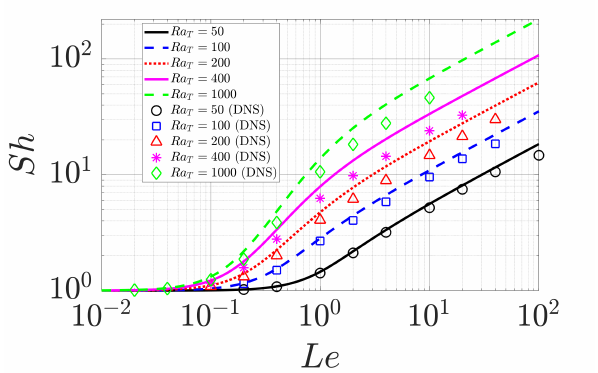
Figure 7. Sh as a function of Le from single-mode solutions (lines) with R ρ = 0 compared with DNS (markers) from Figure 6 and Table 3 in [39]. The horizontal wavenumbers are chosen as k x = π , 1.25 π , 2 π , 3 π , 5.83 π for Ra T = 50, 100, 200, 400, 1000 based on k x = n π / L x ,NBC with n and L x ,NBC as in